Question: Which visualization type does this figure use?
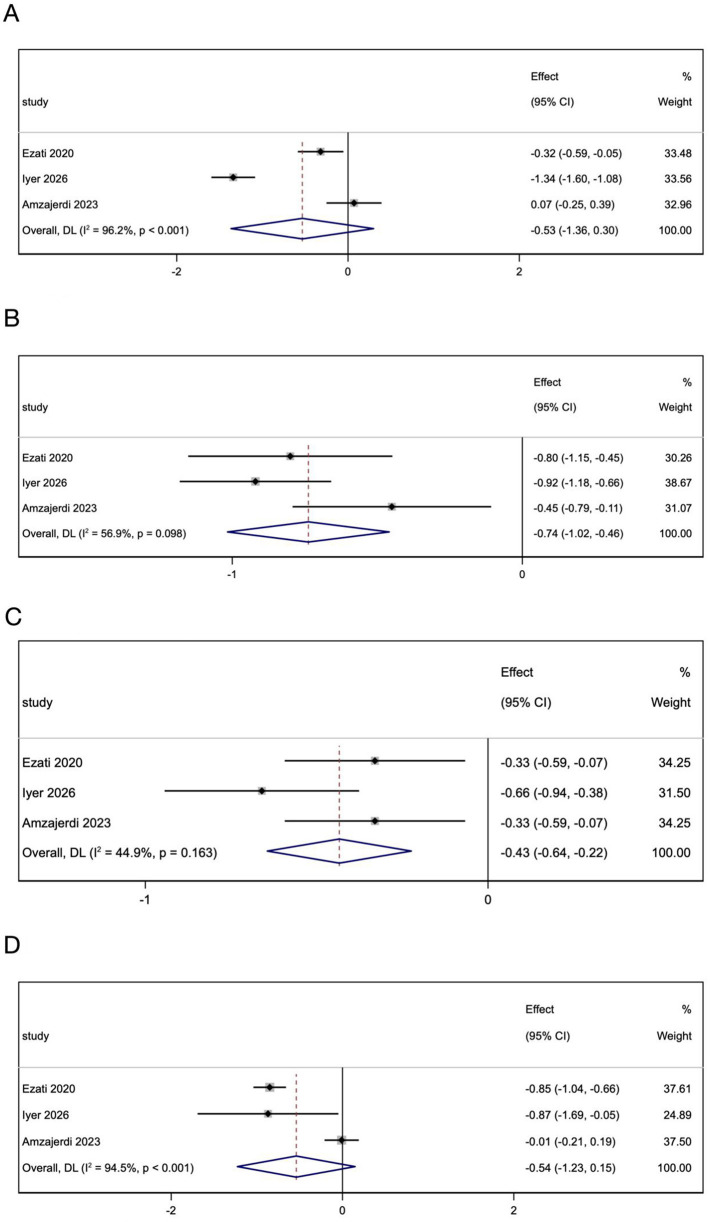
Answer: forest